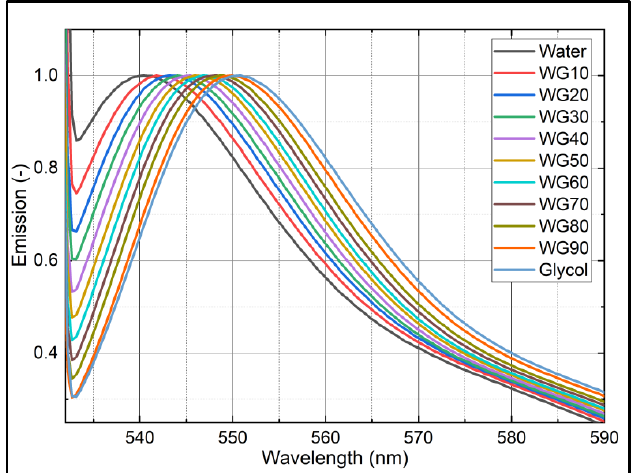
Figure A2. Normalized emission spectra of Eosin-Y (9.38 mg/L) in various water glycol mixtures, 293 K.